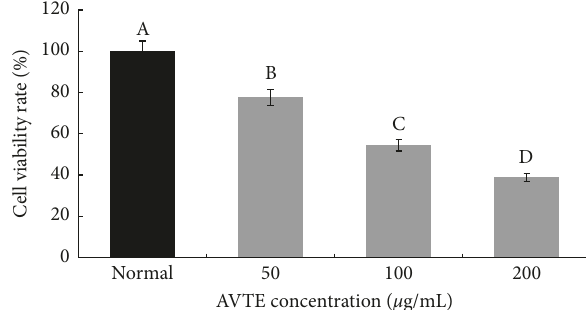
Figure 4: Cell viability of HepG2 cells treated with AVTE as evaluated using MTT assays. a-d Mean values with different letters in the same bar graph are significantly different ( P < 0 . 05) according to Duncan’s multiple range test.